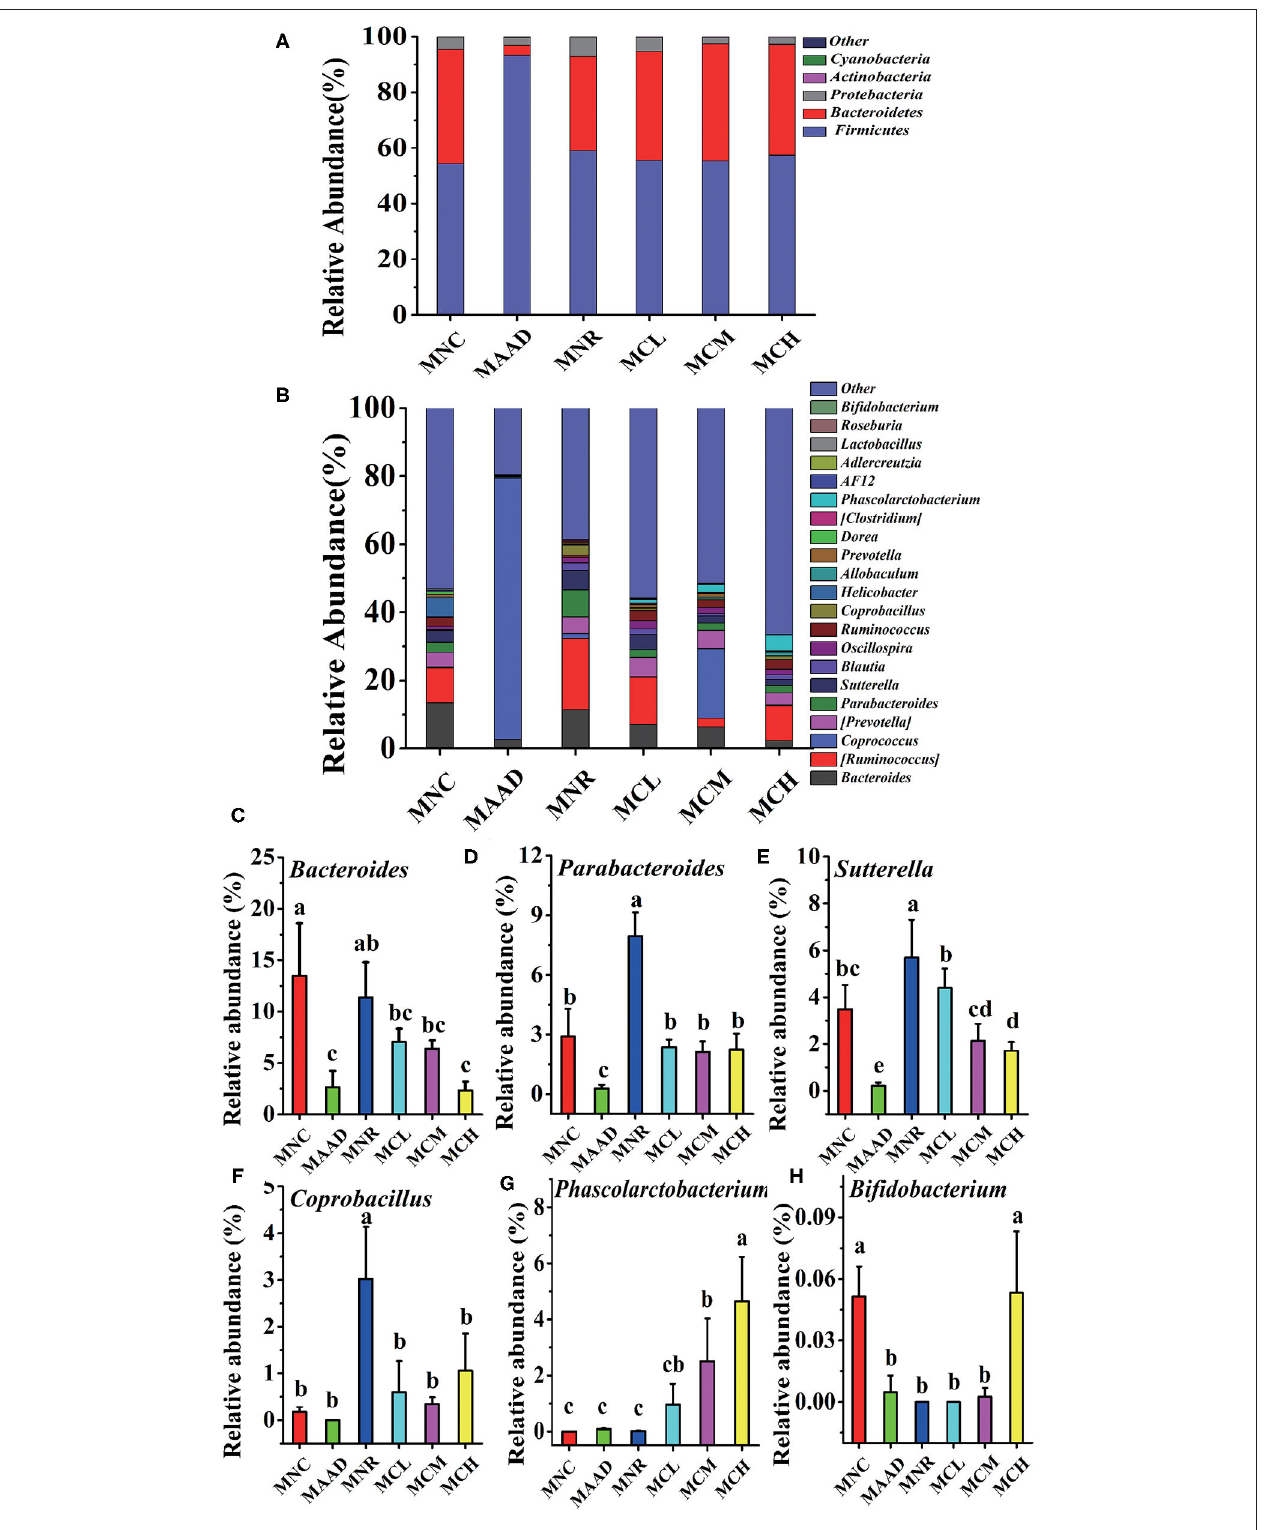
FIGURE 6 | Changes of microbial communities at different levels. (A,B) Phylum and Genus levels. (C–H) Comparison of intestinal flora with major differences at the genus level. Values are shown as means ± SD.